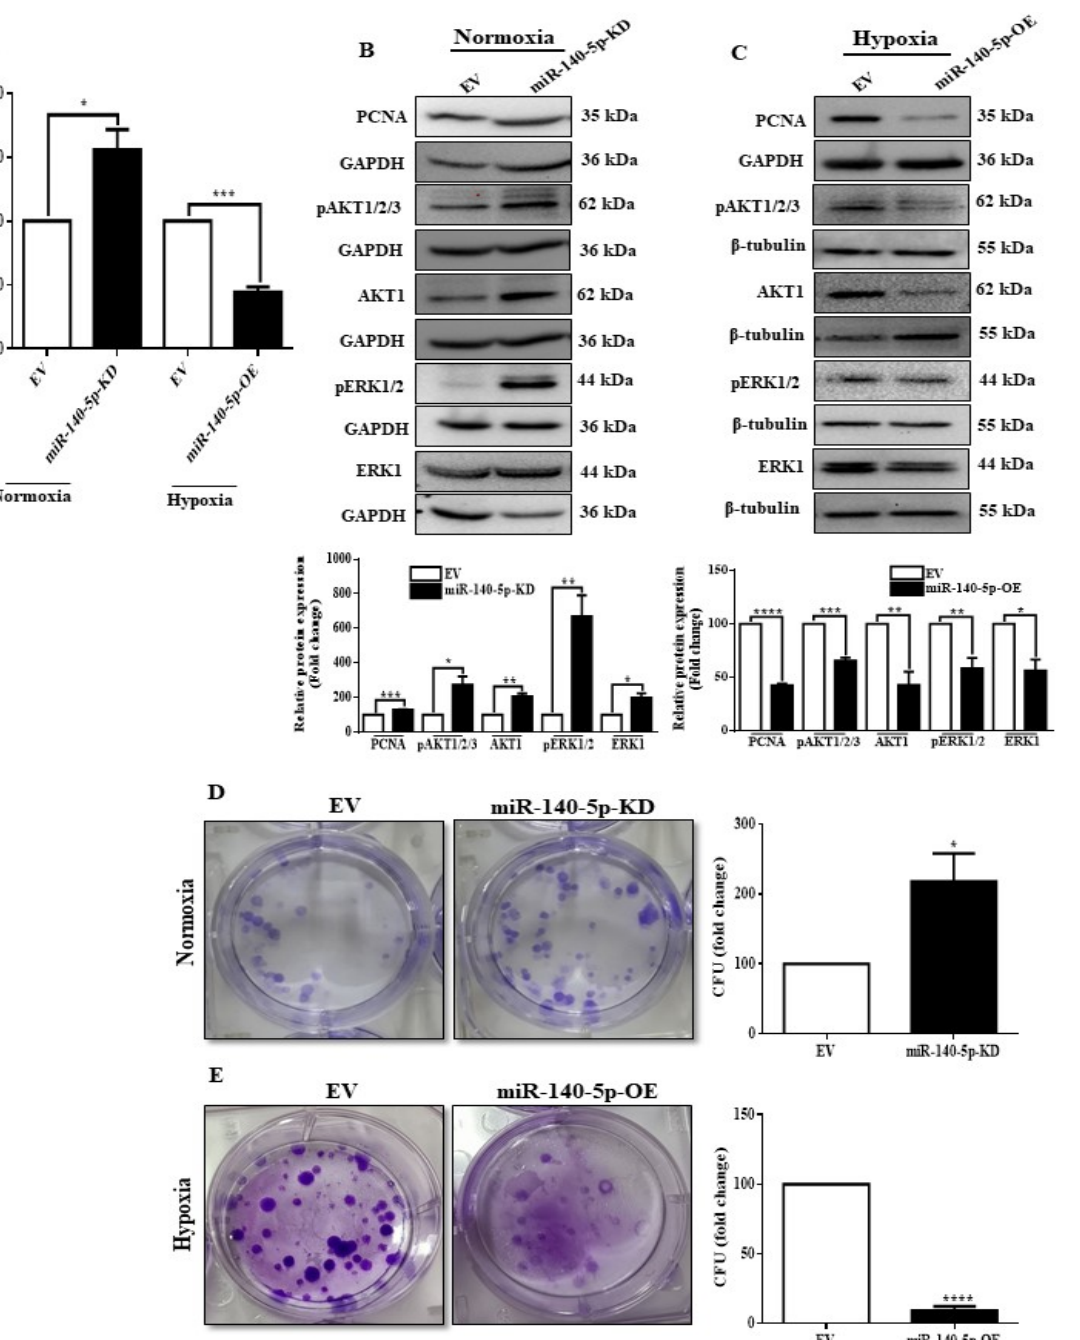
Figure 4. miR ‐ 140 ‐ 5p regulates BC cell growth and colony formation. ( A ) MTT assay to determine cell viability of MDA ‐ MB ‐ 231 to examine the effect of miR ‐ 140 ‐ 5p knockdown under normoxia or overexpression under hypoxia. ( B , C ) Cell proliferation was assessed by examining proliferation markers by Western blotting after stable miR ‐ 140 ‐ 5p knockdown under normoxia or overexpression under hypoxia. ( D , E ) Colony ‐ forming ability was assessed after stable miR ‐ 140 ‐ 5p knockdown under normoxia or overexpression under hypoxia. Error bars indicate mean ± SEM ( n = 3). Student’s t ‐ tests were used to compare the means of two groups. * p < 0.05, ** p < 0.01, *** p < 0.001, and **** p < 0.0001 compared to